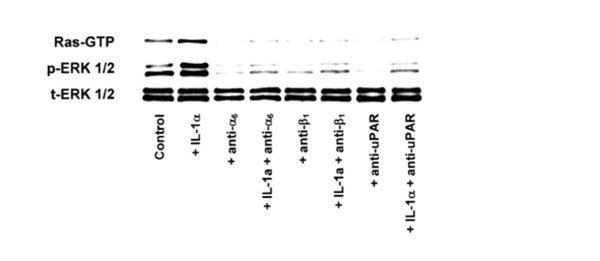
Effect of IL-1α on the activation of Ras and ERK pathway in SW1990 cell lines. Activation of Ras and downstream ERK was performed as described in Materials and Methods. SW1990 cells were serum starved for 24 h and then treated with IL-1α in the presence or absence of inhibitory antibodies for 30 min. Cell lysates were prepared according to the instructions provided in the Ras Activation Assay Kit, and affinity precipitation of GTP-bound Ras was performed using GST-tagged Raf-RBD. Levels of pull-downed Ras (Ras-GTP) were determined by anti-Ras immunoblotting. Effect of IL-1α and α6, β1 integrin and uPAR inhibitory antibodies on the baseline/IL-1α-induced activation of ERK was also examined by immunoblotting. Detection of total ERK 1/2 levels served as a loading control.